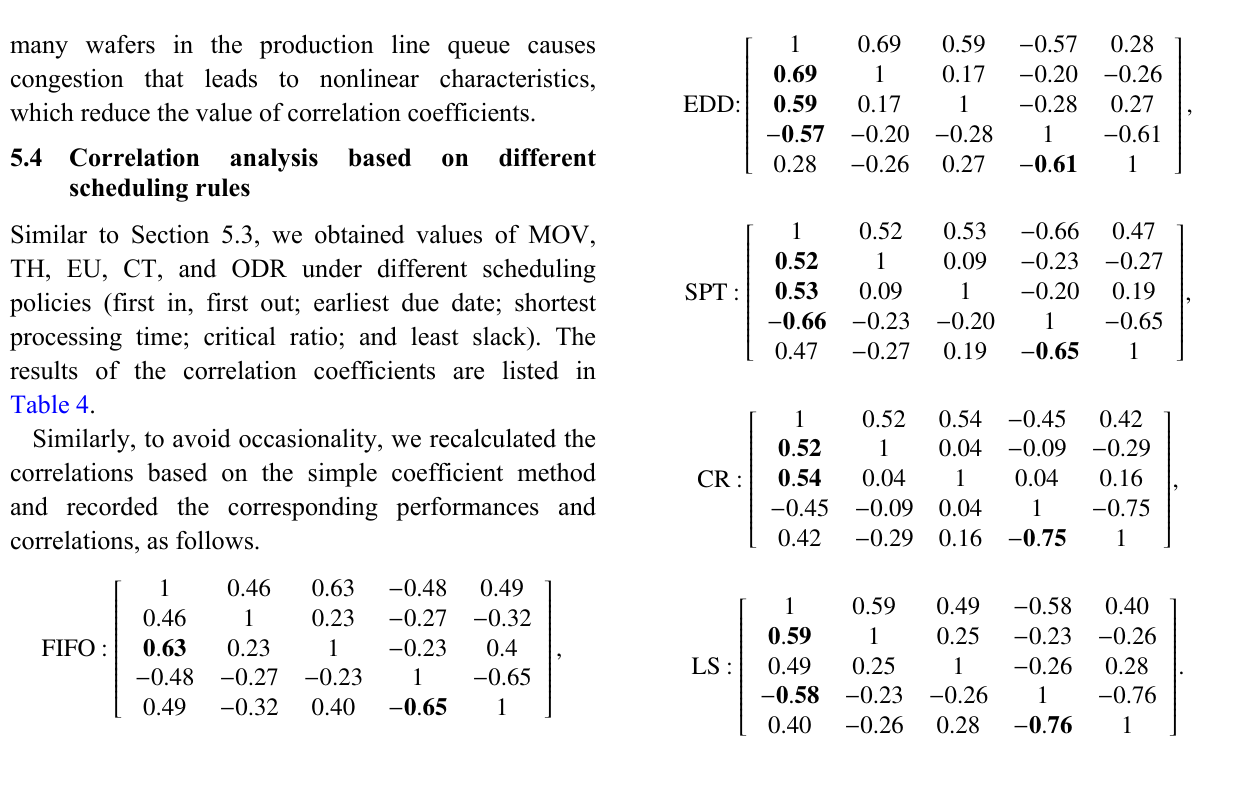
Table 4 Correlation coefficients among performances in different scheduling